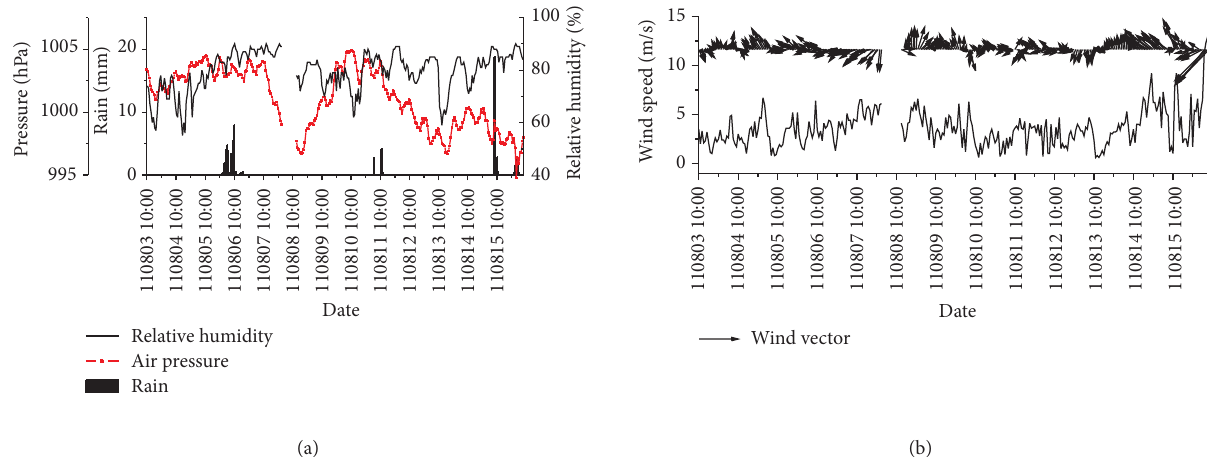
Figure 3: Inter-diurnal variation of meteorological elements ((a) relative humidity, precipitation, surface pressure; (b) wind speed and wind direction).